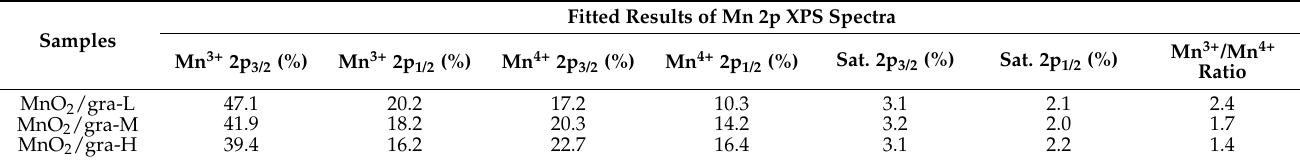
Table 3. Fitted results of Mn 2p XPS